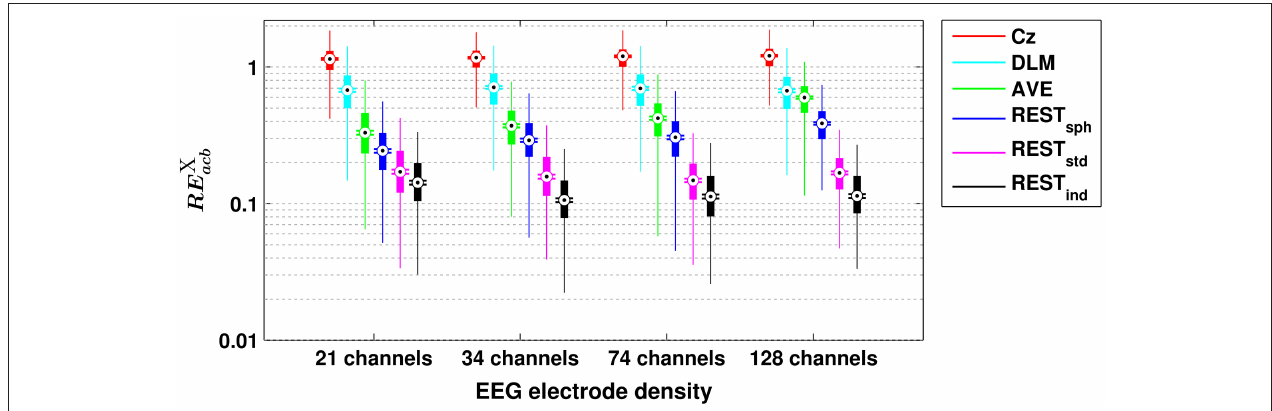
FIGURE 3 | Box plots for the relative error for antisymmetric cross-bicoherence ( RE X acb ) evaluated with different EEG reference schemes and with different EEG electrode densities. The ordinate axis is logarithmically scaled. Each box plot displays the RE-values from 1,000 simulation repetitions.